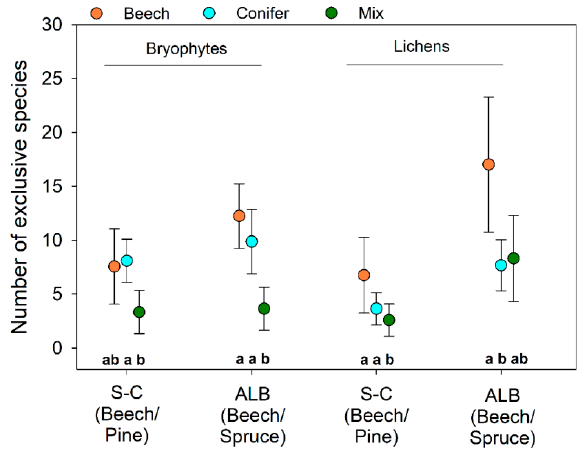
Figure 6. Mean number of exclusive bryophyte and lichen species in pure beech, pure conifer and mixed stands of Schorfheide-Chorin (S-C) and Schwäbische Alb (ALB) based on pairwise comparisons of 1000 resamplings of plots per stand type and region (number of resampled plots see Table 3). Error bars indicate the 95% quantile of resamplings. Different lowercase letters indicate significant differences among stand types within regions (i.e., at least 975 of 1000 pairwise comparisons showed higher number of exclusive species of one stand type compared to the